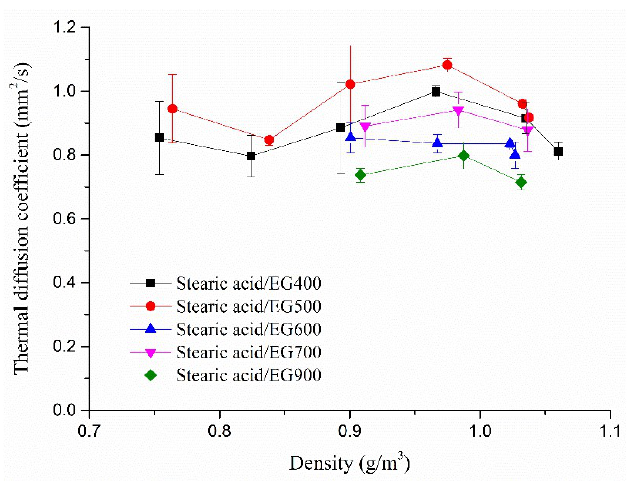
Figure 4. The thermal diffusion coefficients of stearic acid/EG composites with different densities.